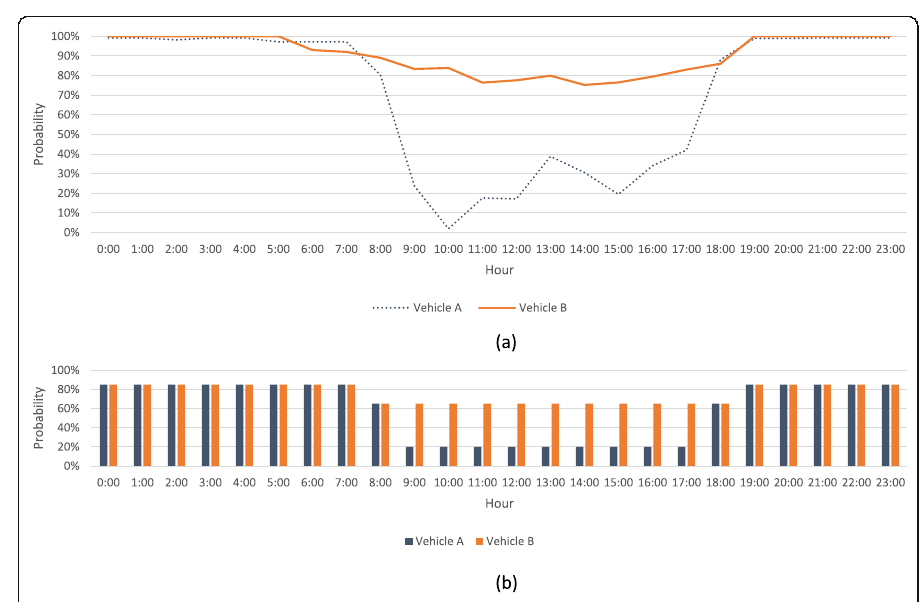
Fig. 3 ( a ) Probability distributions showing the likelihood of proximity to defined locations of V2G charge points for each hour during a typical weekday for 2 sample vehicles tracked using a commercial vehicle tracking service, ( b ) generalised probability distributions derived from these profiles that were used in the